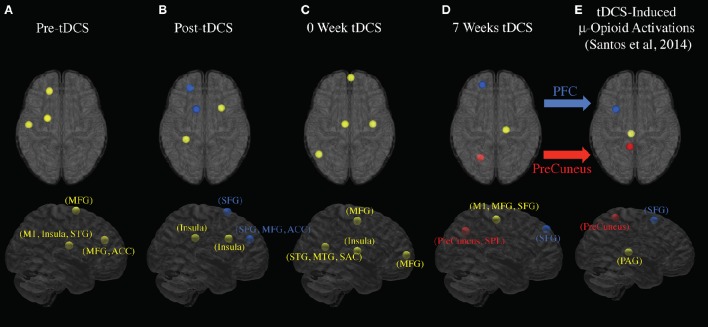
EEG signal sources changes to PFC and PreCuneus following 7 weeks of tDCS stimulation. The estimated locations of the EEG sources are marked out for each stage. The blue, red, and yellow dots indicate, respectively, the sources with possible locations at SFG, PreCuneus, and other areas. (A) Estimated signal sources before tDCS stimulation (average of week 2, 3, and 7). (B) Estimated signal sources immediately after tDCS stimulation (average of week 2, 3, and 7). (C) Estimated signal sources in pre-study visit week. (D) Estimated signal sources in week seven. (E) Estimated tDCS-induced mu-opioid activation locations (DosSantos et al., 2014).